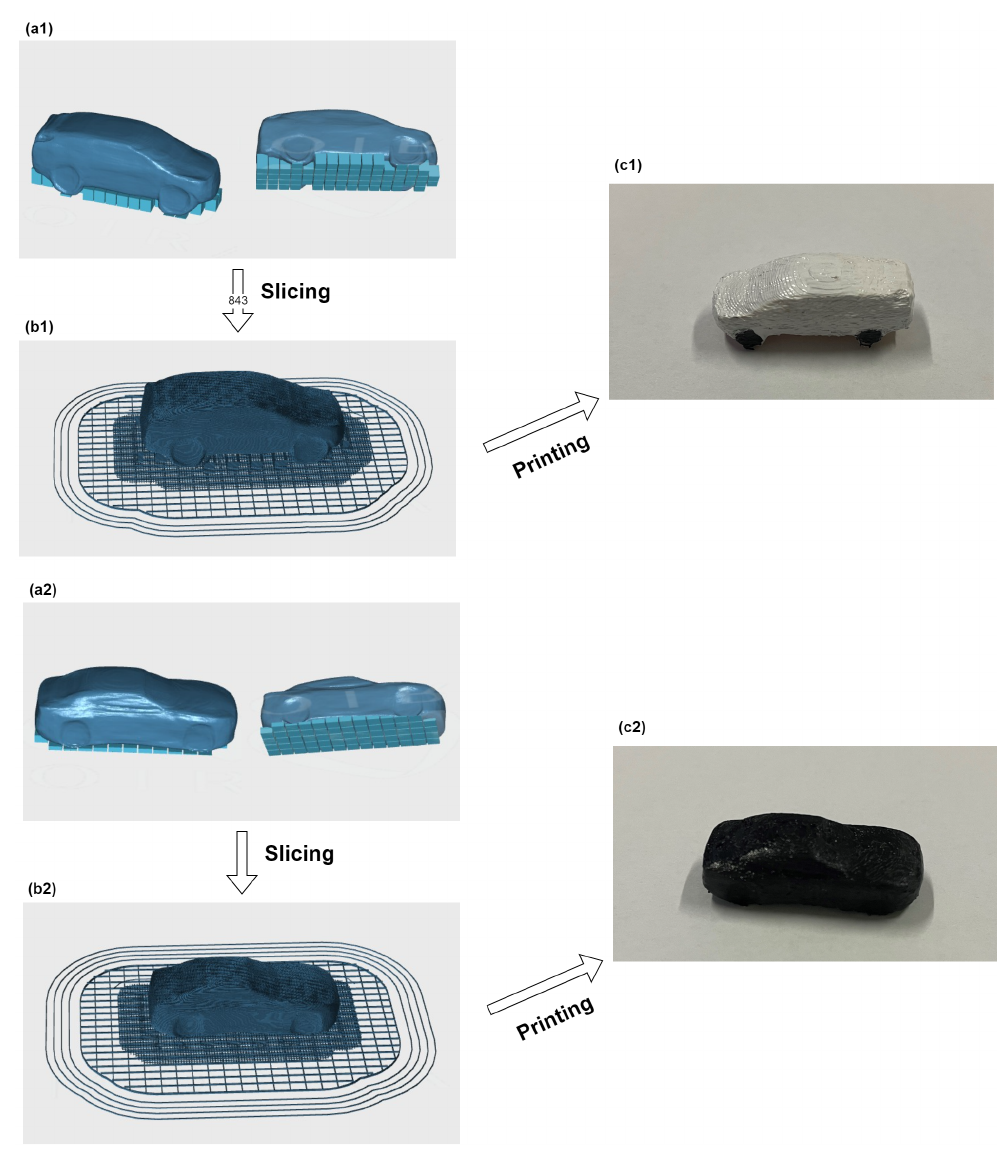
Figure 7. The printing process of two cars. Among them, ( a1 , a2 ) respectively represent the 3D digital models of Picture1 and Picture2 after adding supports, ( b1 , b2 ) represent their sliced models respectively, and ( c1 , c2 ) correspond to the printed small solid models